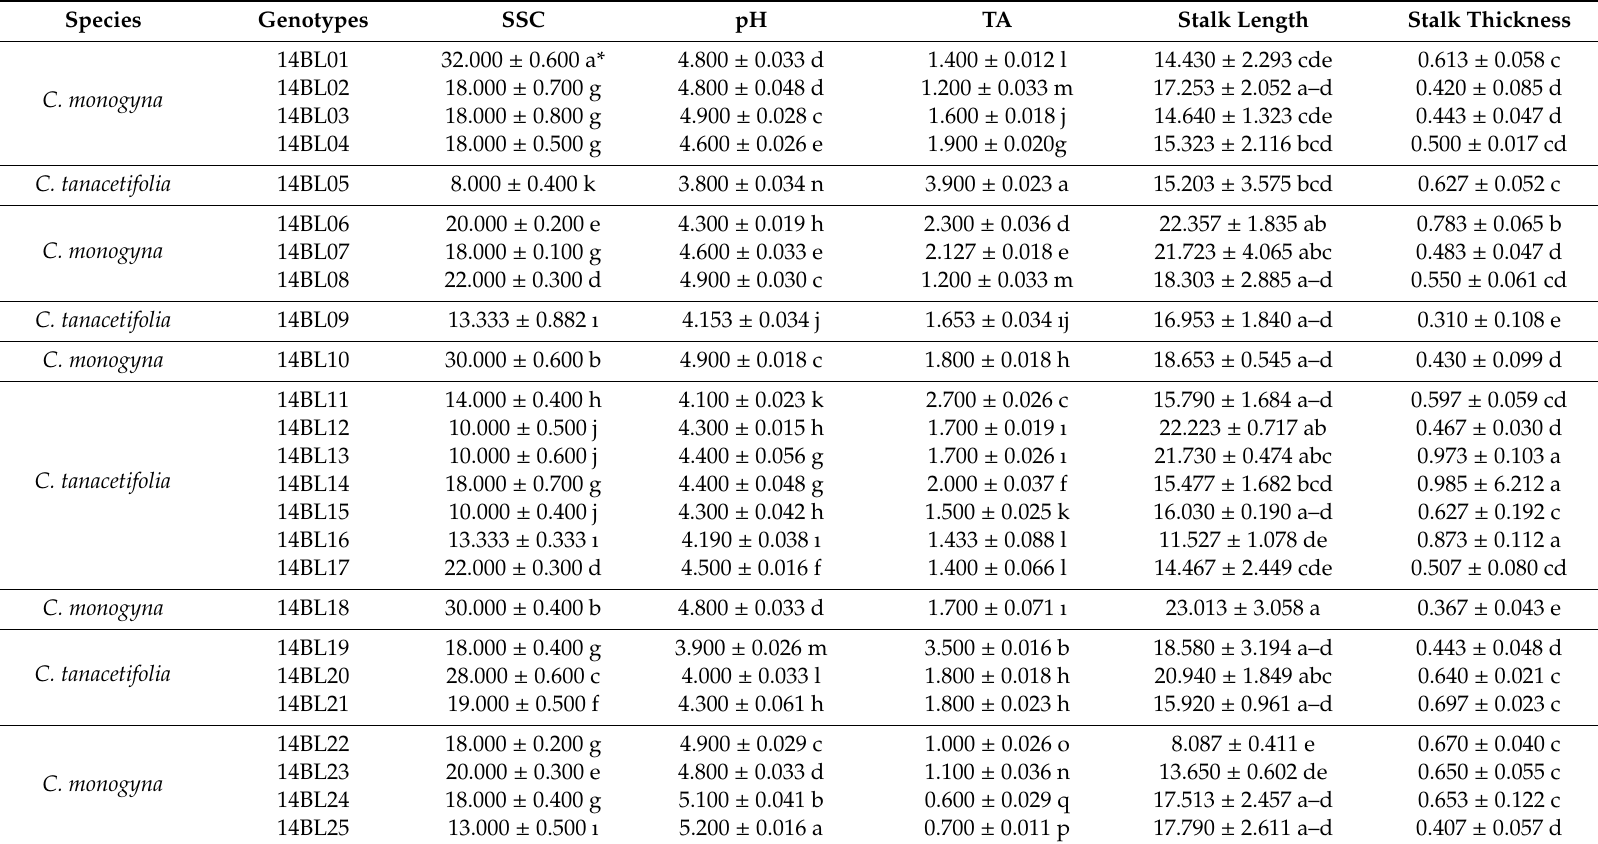
Table 4. Stalk length and thickness (mm), soluble solid content (SSC) (% Brix), pH and titratable acidity (TA) (%) contents of hawthorn